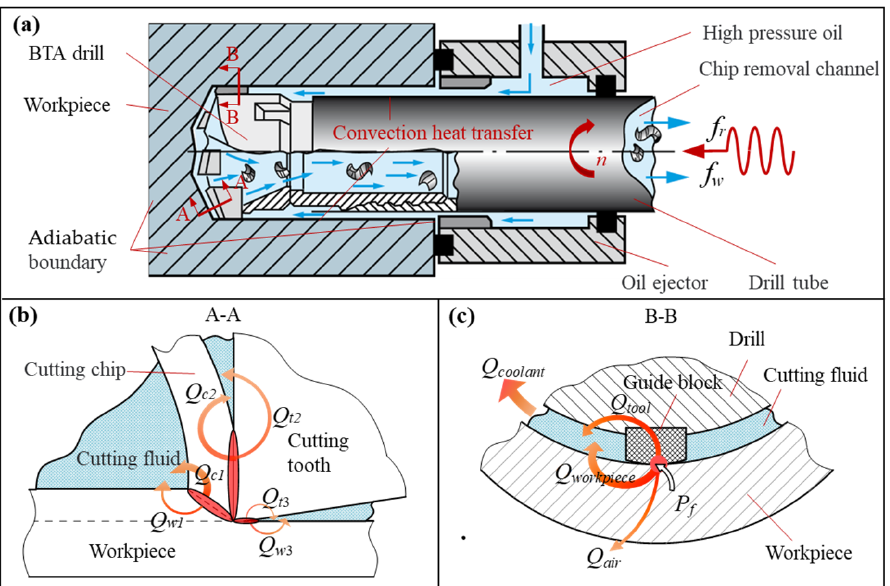
Figure 1. ( a ) The working principle diagram and heat conduction boundary conditions of the BTA deep hole vibration drilling. ( b ) Heat conduction model of the cutter teeth. ( c ) Guide block extrusion friction heat conduction model.